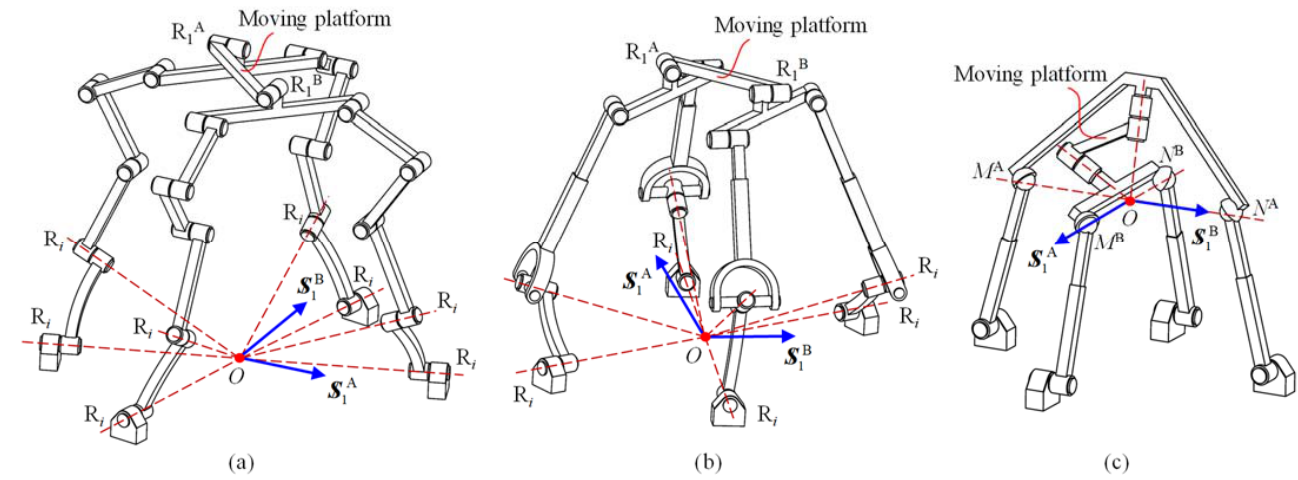
Figure 6. Typical non ‐ overconstrained 3R1T PMs: ( a ) 2([R i R i R 11 R 11 R 11 ‐ R i R i R 12 R 12 R 12 ] ‐ R 1 ) PM, ( b ) 2([R i UPR 11 ‐ R i UPR 12 ] ‐ R 1 ) PM, ( c ) 2([R 1 PS ‐ R 1 PS] ‐ R O ) PM.